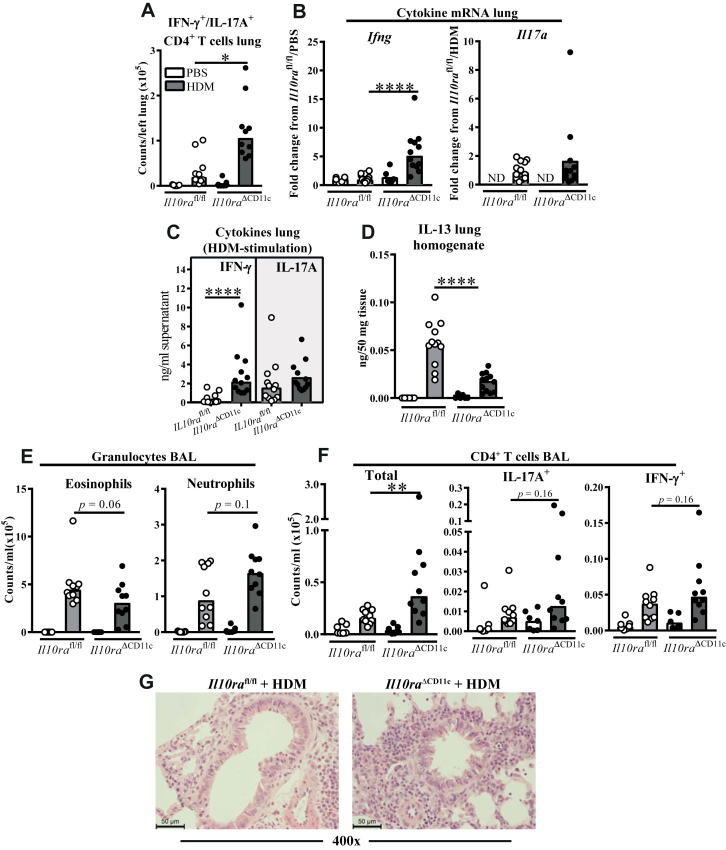
Immune response to HDM in Il10raΔCD11c mice. A, IFN-γ/IL-17A double-positive CD4+ T cells, as determined by using flow cytometry. B, Fold changes in Ifng and Il17a mRNA expression in homogenized lung tissue. C and D, Concentrations of cytokines in supernatants of HDM-stimulated lung cell suspensions (Fig E6, C) and homogenized lung tissue (Fig E6, D). E and F, Flow cytometric data showing numbers of eosinophils and neutrophils (Fig E6, E) and IFN-γ+ and IL-17A+ CD4+ T cells (Fig E6, F) in BAL fluid. G, Representative images of hematoxylin and eosin–stained lung sections showing epithelial damage quantified in Fig 6. Data are pooled from 2 experiments and show medians and individual replicates (n = 4-13 per group). *P < .05, **P < .01, and ****P < .0001. ND, Not detected.